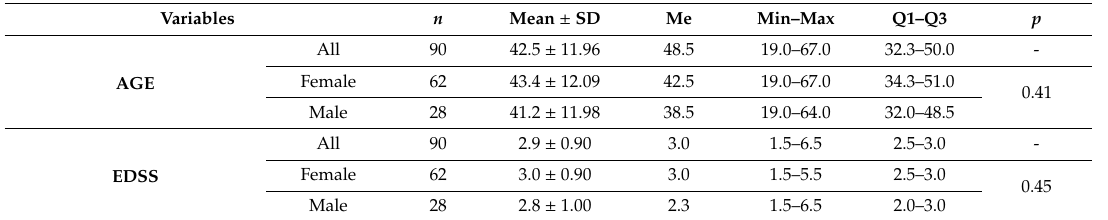
Table 1. Mean ± SD, median, min–max, lower and upper quartile in blood biochemical parameters, survey results, and significance of gender-specific di ff